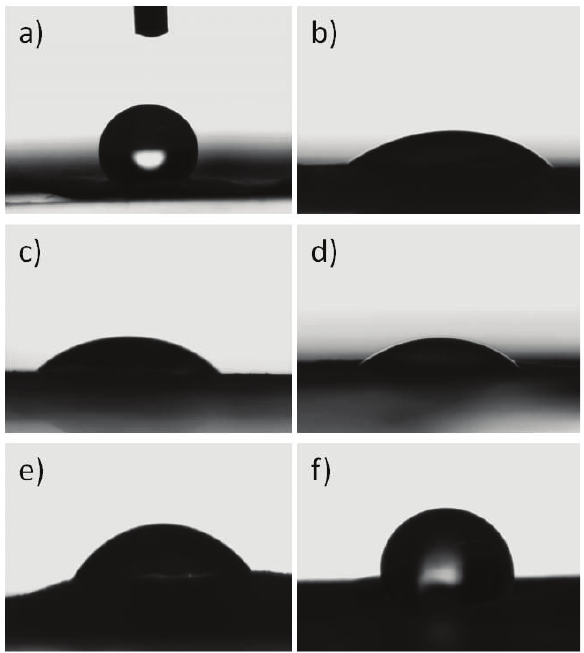
Fig. 3 – Water drops on the surface of the electrospun scaf- folds: a) 18 % PCL, b) 10 % PCL/SF, c) 12 % PCL/SF, d) 14